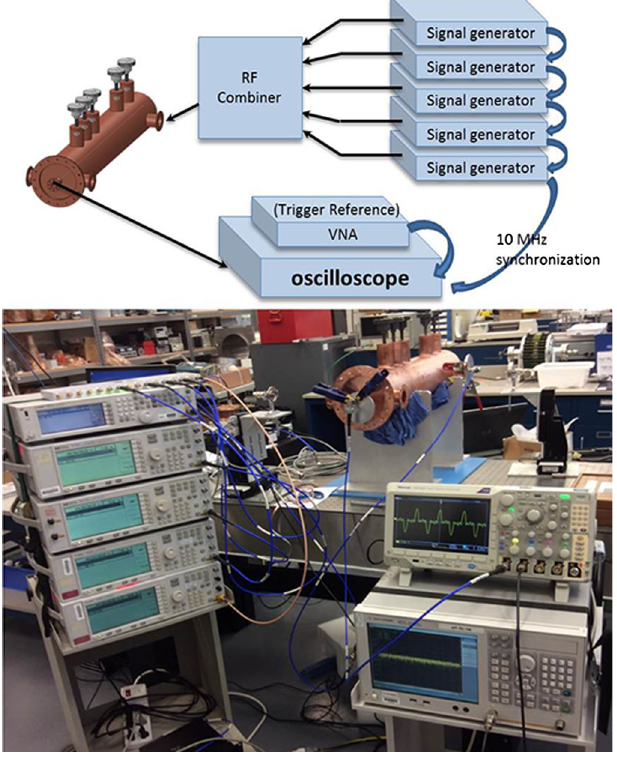
FIG. 21. Schematic drawing (top) and bench set up (bottom) for the mode combination experiment.